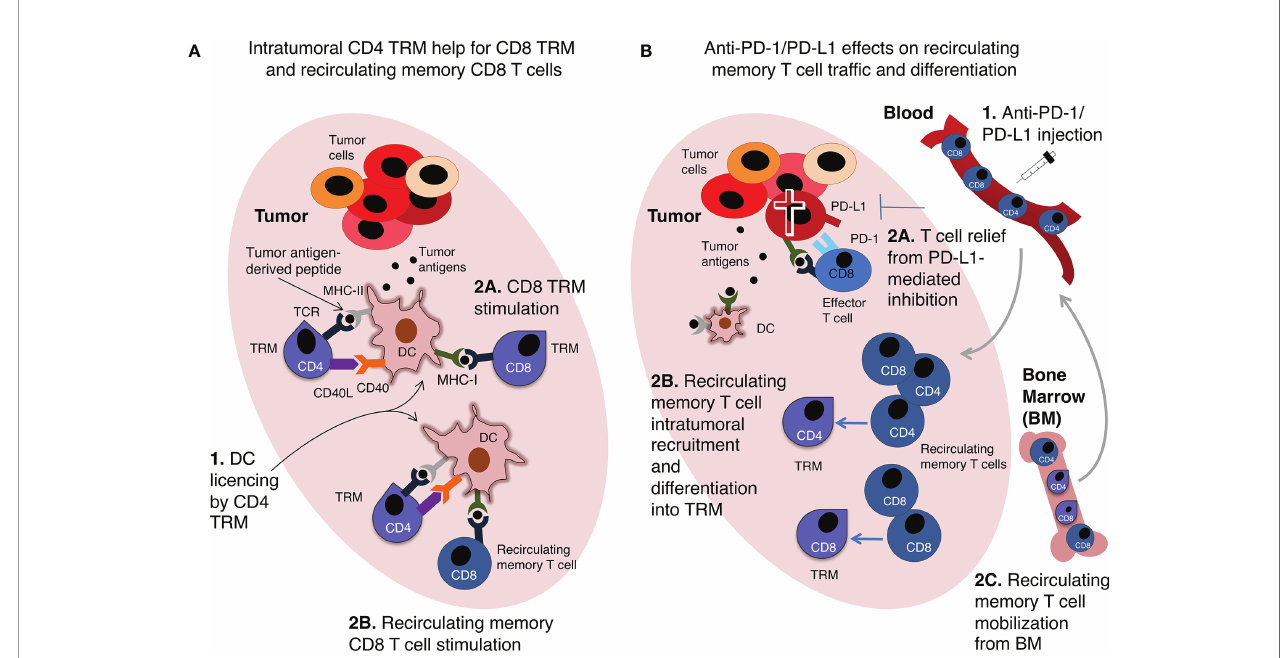
FIGURE 3 | Tissue-resident memory T cells (TRM) and recirculating memory T cell collaboration in anti-tumor immunity. Two examples of possible interplay between TRM and recirculating memory T cell are shown. (A) Intratumoral CD4 TRM provide help to recirculating memory CD8 T cells and CD8 TRM. A hypothetical scenario of intratumoral DCs presenting tumor antigen-derived peptides to memory CD4 and CD8 T cells is shown. In this scenario, memory CD4 T cells are intratumoral TRM, and license DCs via CD40L-CD40 interaction (1). This enables DCs to fully stimulate either CD8 TRM (2A) or recirculating memory CD8 T cells (2B). (B) Recirculating memory T cells unleashed by anti-PD-1/PD-L1 therapy promote intratumoral TRM response. Upon anti-PD-1/PD-L1 intravenous injection (1), tumor-speci fi c effector CD8 T cells expressing PD-1 are relieved from PD-L1-mediated inhibition and kill tumor cells (2A) . Recirculating memory CD4 and CD8 T cells migrate via blood into the tumor, and differentiate into TRM (2B) , augmenting TIL number and anti-tumoral activity. Recirculating memory CD4 and CD8 T cells are mobilized from BM into the blood, and are then recruited into the tumor, thus contributing to re-invigorate anti-tumor T cell immunity (2C) . These hypothetical examples echo data obtained in mouse models of immune response against viruses (A) (116) and transplanted tumors (B)